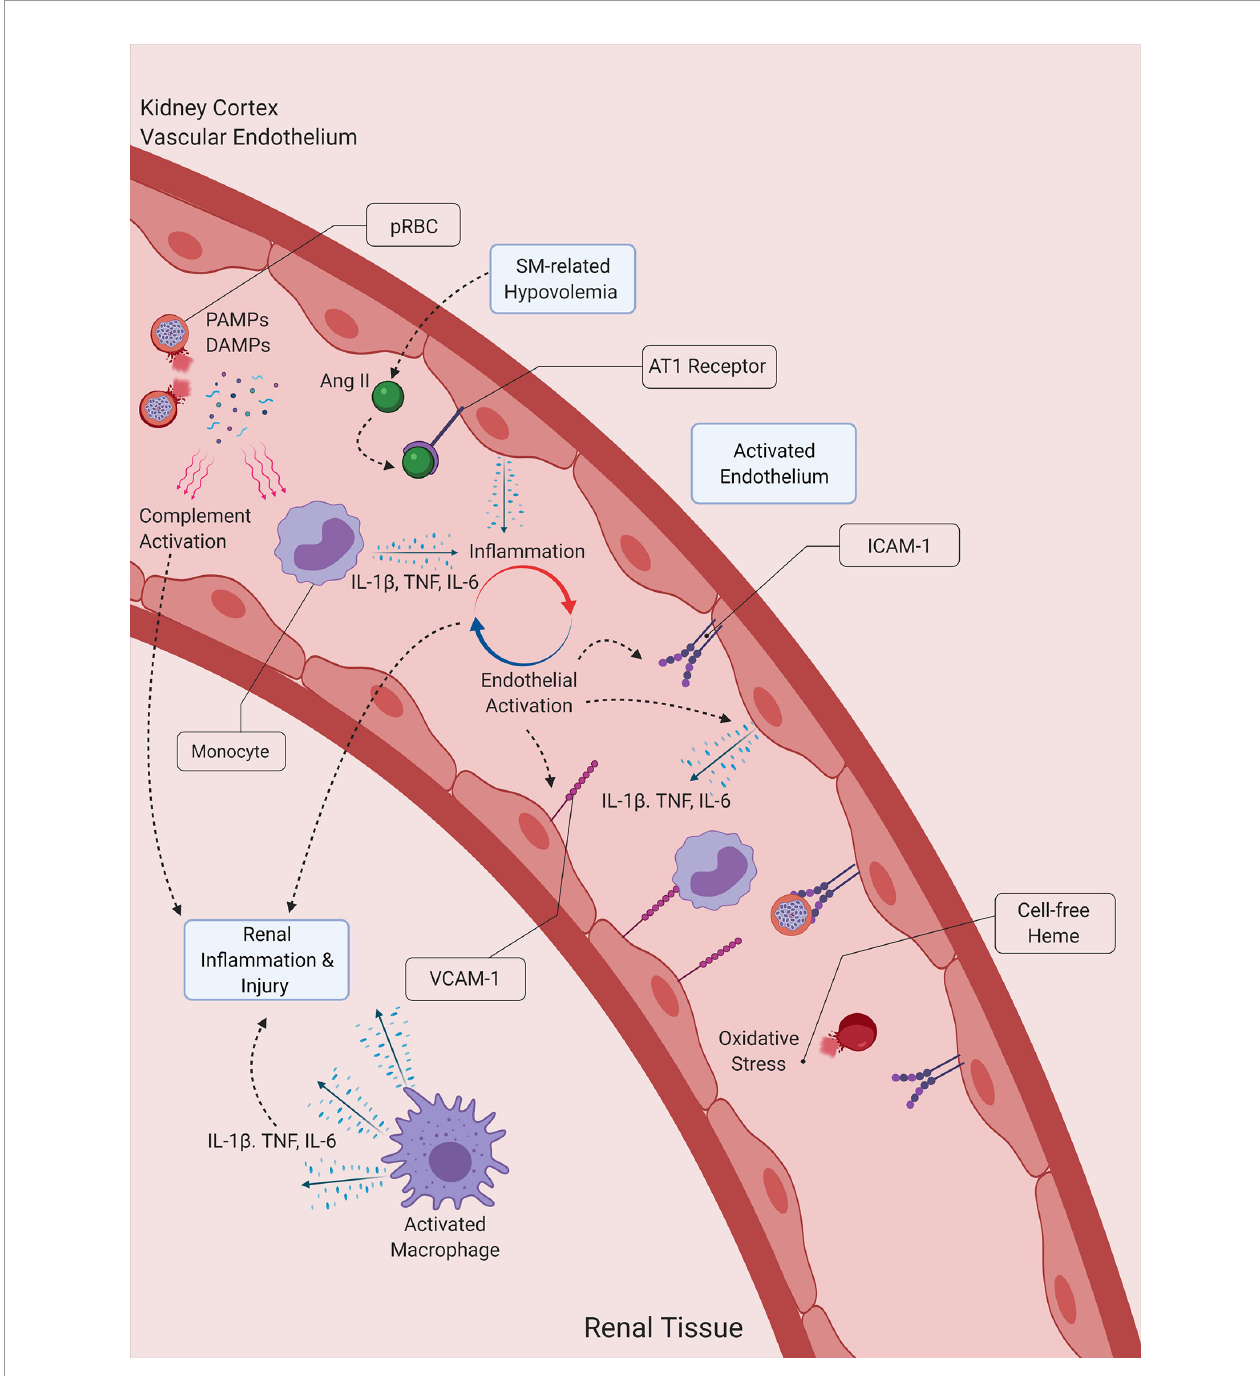
FIGURE 2 | Proposed interactions between in fl ammation, hemolysis and hypovolemia in malaria-induced kidney injury. Malaria PAMPs and DAMPs released during the lysis of Plasmodium -infected RBCs (pRBCs) stimulate the immune and in fl ammatory responses, leading to the secretion of proin fl ammatory cytokines, which subsequently induce the activation of the endothelium and the propagation of the in fl ammatory process. Activated endothelial cells contribute to the secretion of proin fl ammatory cytokines, and express surface receptors that facilitate the in fi ltration of leukocytes into kidney tissue. Cell-free heme acts a source of oxidative stress for the vascular endothelium and the tubular epithelial cells of the kidney, while also inducing the formation of NETs. The activation of the angiotensin (Ang) II/ AT1 receptor pathway due to malaria-induced hypovolemia also contributes to the ampli fi cation of the host in fl ammatory response, by further inducing the secretion of proin fl ammatory cytokines by endothelial cells. DAMP, Damage-associated molecular pattern ICAM-1, Intercellular adhesion molecule 1, IL-1 b , Interleukin-1 b ; IL-6, Interleukin-6; NET, Neutrophil extracellular trap; PAMP, Pathogen-associated molecular pattern; SM, Severe malaria, TNF, Tumor necrosis factor; VCAM-1, Vascular cell adhesion molecule